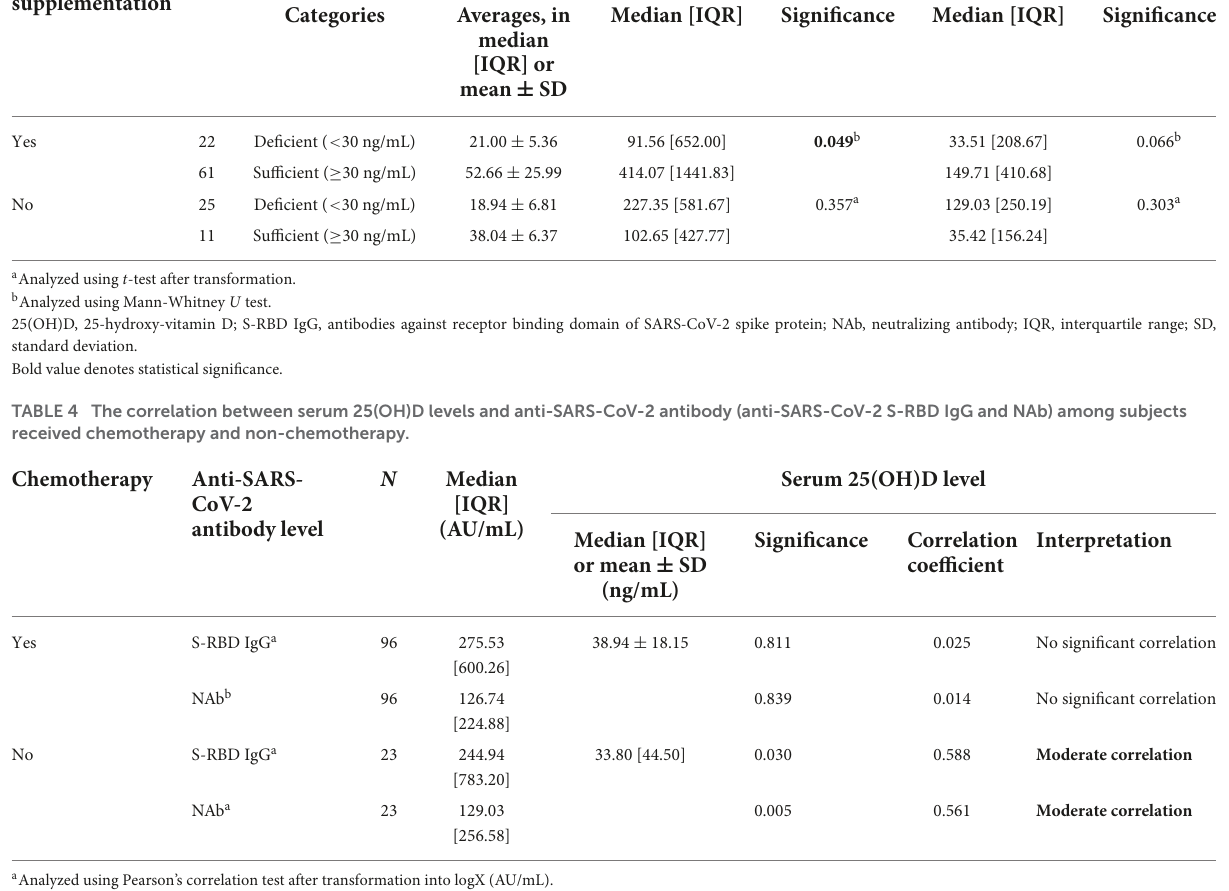
TABLE 3 The comparison between serum 25(OH)D levels and anti-SARS-CoV-2 antibody (anti-SARS-CoV-2 S-RBD IgG and NAb) levels in subjects subgroup by vitamin D 3 supplementation daily consumption. Vitamin D 3 daily supplementation